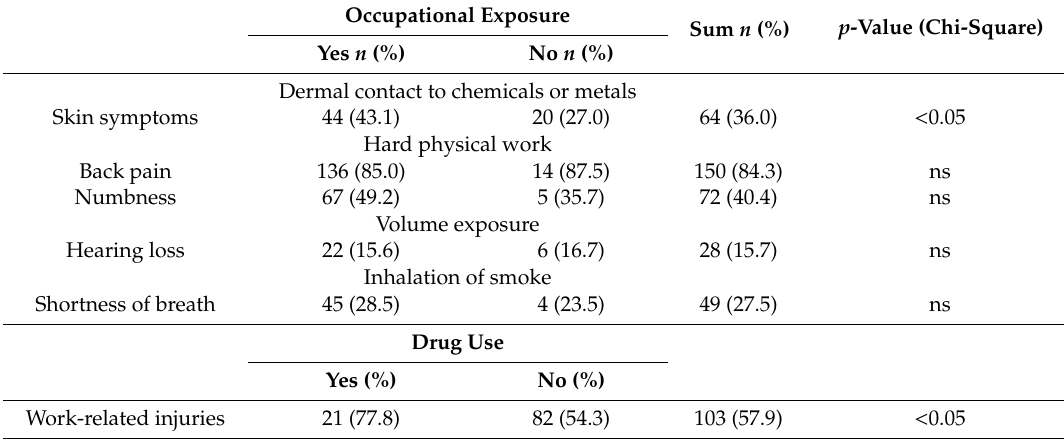
Table 4. Association between specific occupational exposures and medical conditions (for all workers, n =